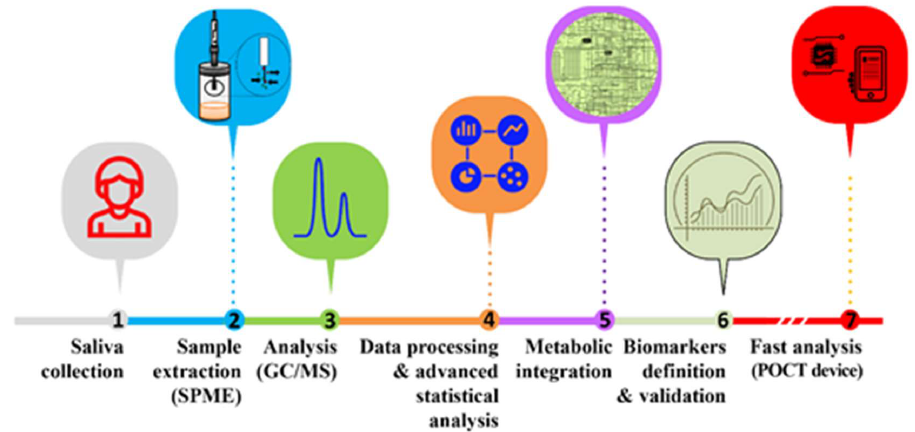
Figure 2. Typical experimental layout for the analysis of salivary VOCs and identification of putative volatile biomarkers for the clinical environment using POCT devices ([95,96]).